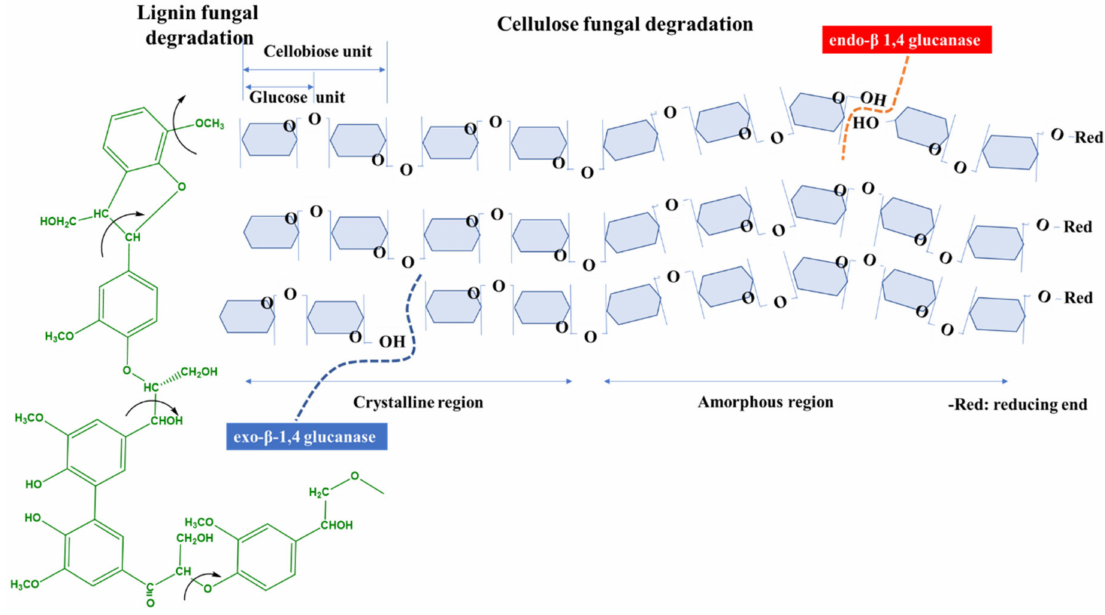
Figure 2. Schematic depiction of lignin and cellulose chain scission induce by fungal